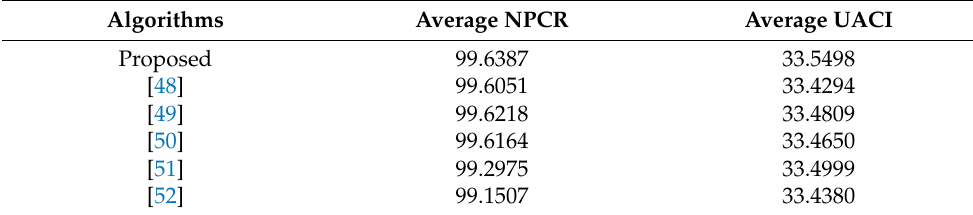
Table 6. Plaintext sensitivity performance compared with previous